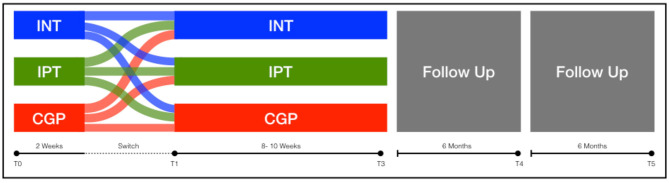
Study flow chart.